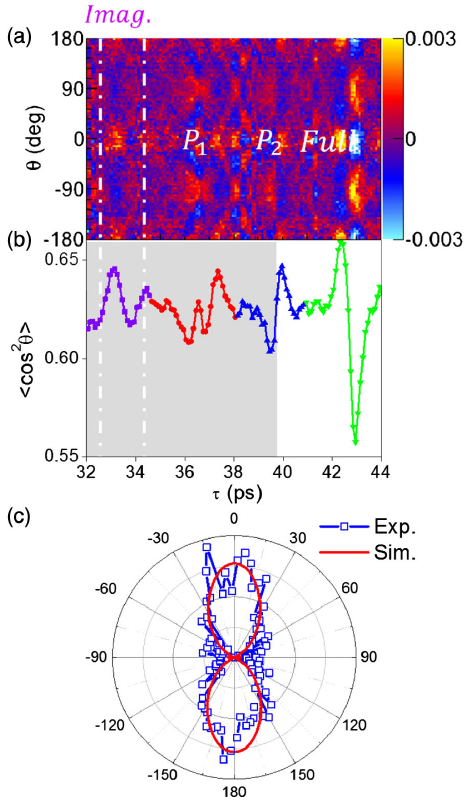
FIG. 7. Experimentally measured and theoretically simulated time-dependent angular distributions of the imaginary echo in CO 2 . P 1 and P 2 arrive at − 2 . 6 ps and 0 ps, respectively. (a) A “ carpet ” describing the angular distribution of the imaginary echo as a function of the probe time delay (see the region of 36 ps – 38 ps between the white dashed lines). (b) The alignment factor h cos 2 θ i as a function of the probe delay (red shows the revival of the response to the first pulse, blue that of the second pulse, green depicts the revival of the first full echo, and purple presents the imaginary echo). (c) Polar plots of the imaginary echo around 36.6 ps (blue shows the experiment and red the simulation).